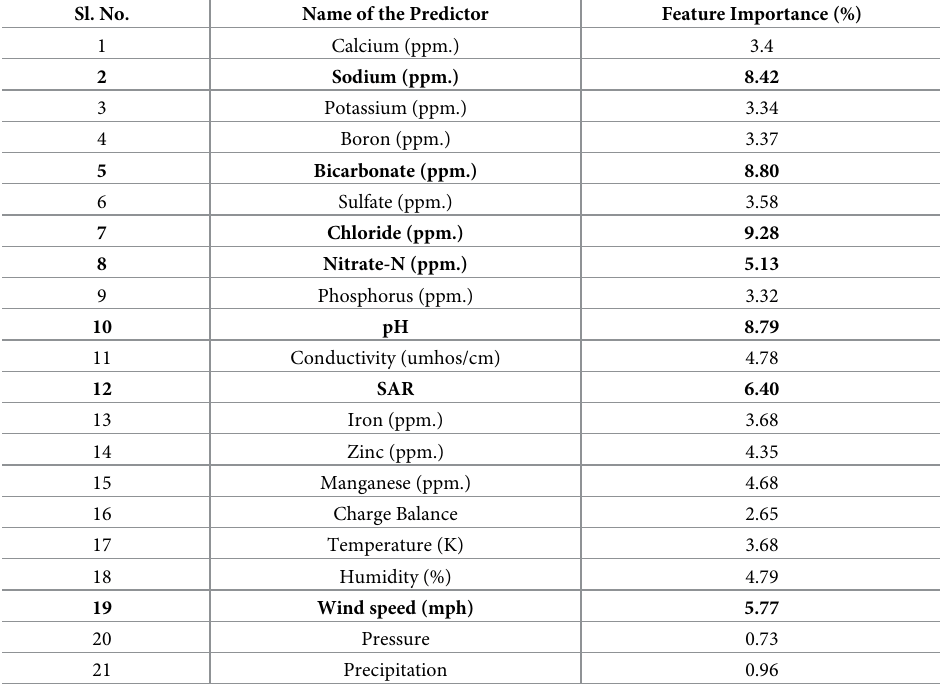
Table 2. Feature importance values of the predictors in the analysis given by the ExtraTreesClassifier. Sl. No. Name of the